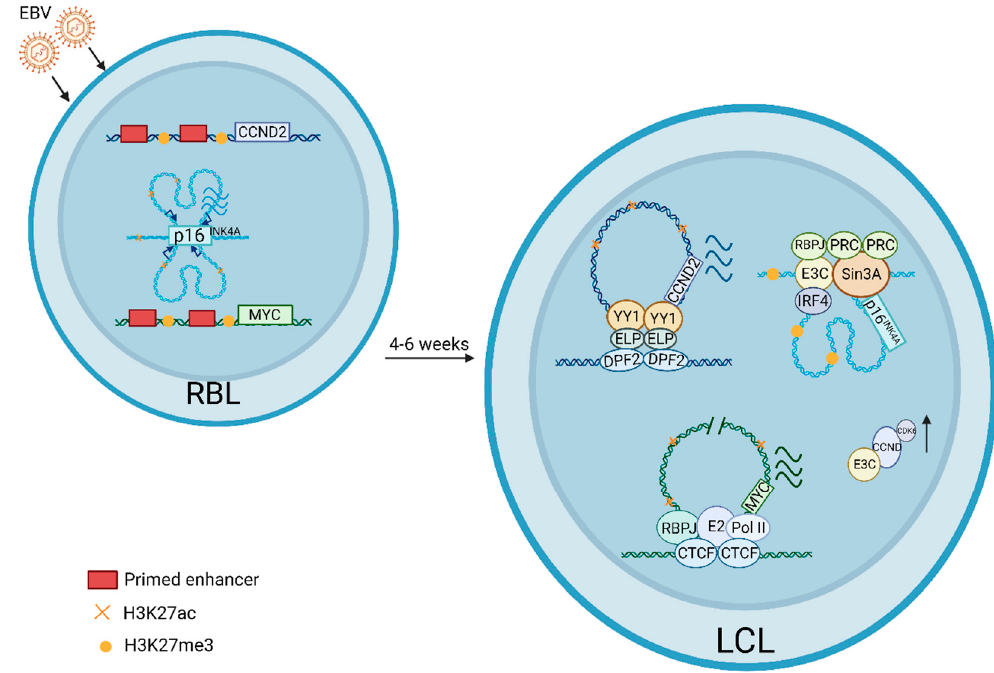
Figure 1. Host enhancer/silencer rewiring following EBV transformation of RBLs into LCLs. In RBLs, MYC and CCND2 are expressed at basal level with few enhancer promoter interactions. p16INK4A is expressed at high level with extensive enhancer–promoter interactions and active enhancer mark H3K27ac. Following EBV transformation, EBNA2 induces enhancers 400–500 kb upstream of MYC to loop to MYC TSS to activate MYC expression. EBNALP recruits YY1 to CCND2 locus and promotes enhancer–promoter interaction to activate CCND2 expression. These loci are now marked by H3K27ac. At the p16INK4A locus, much less enhancer–promoter interactions is seen and EBNA3C recruits transcription repressors Sin3A and polycomb repressive complexes to the